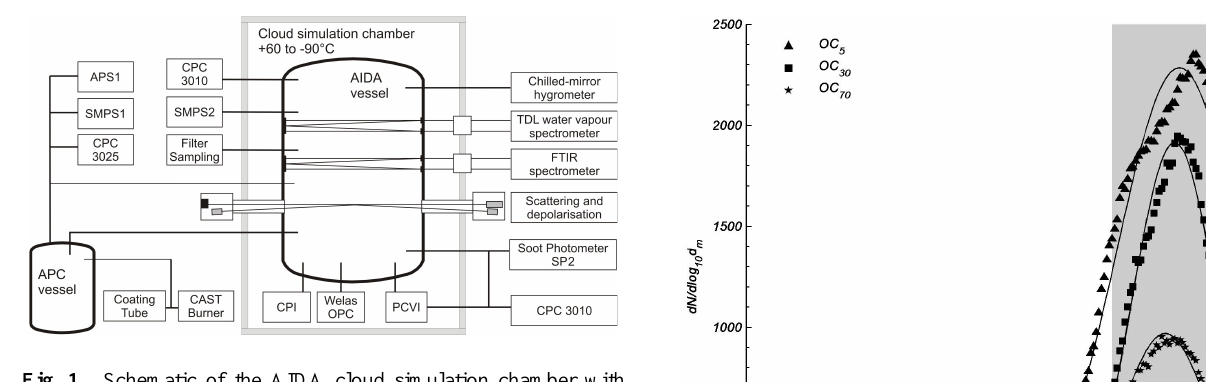
Fig. 1. Schematic of the AIDA cloud simulation chamber with instrumentation for heterogeneous ice nucleation studies of soot aerosols.